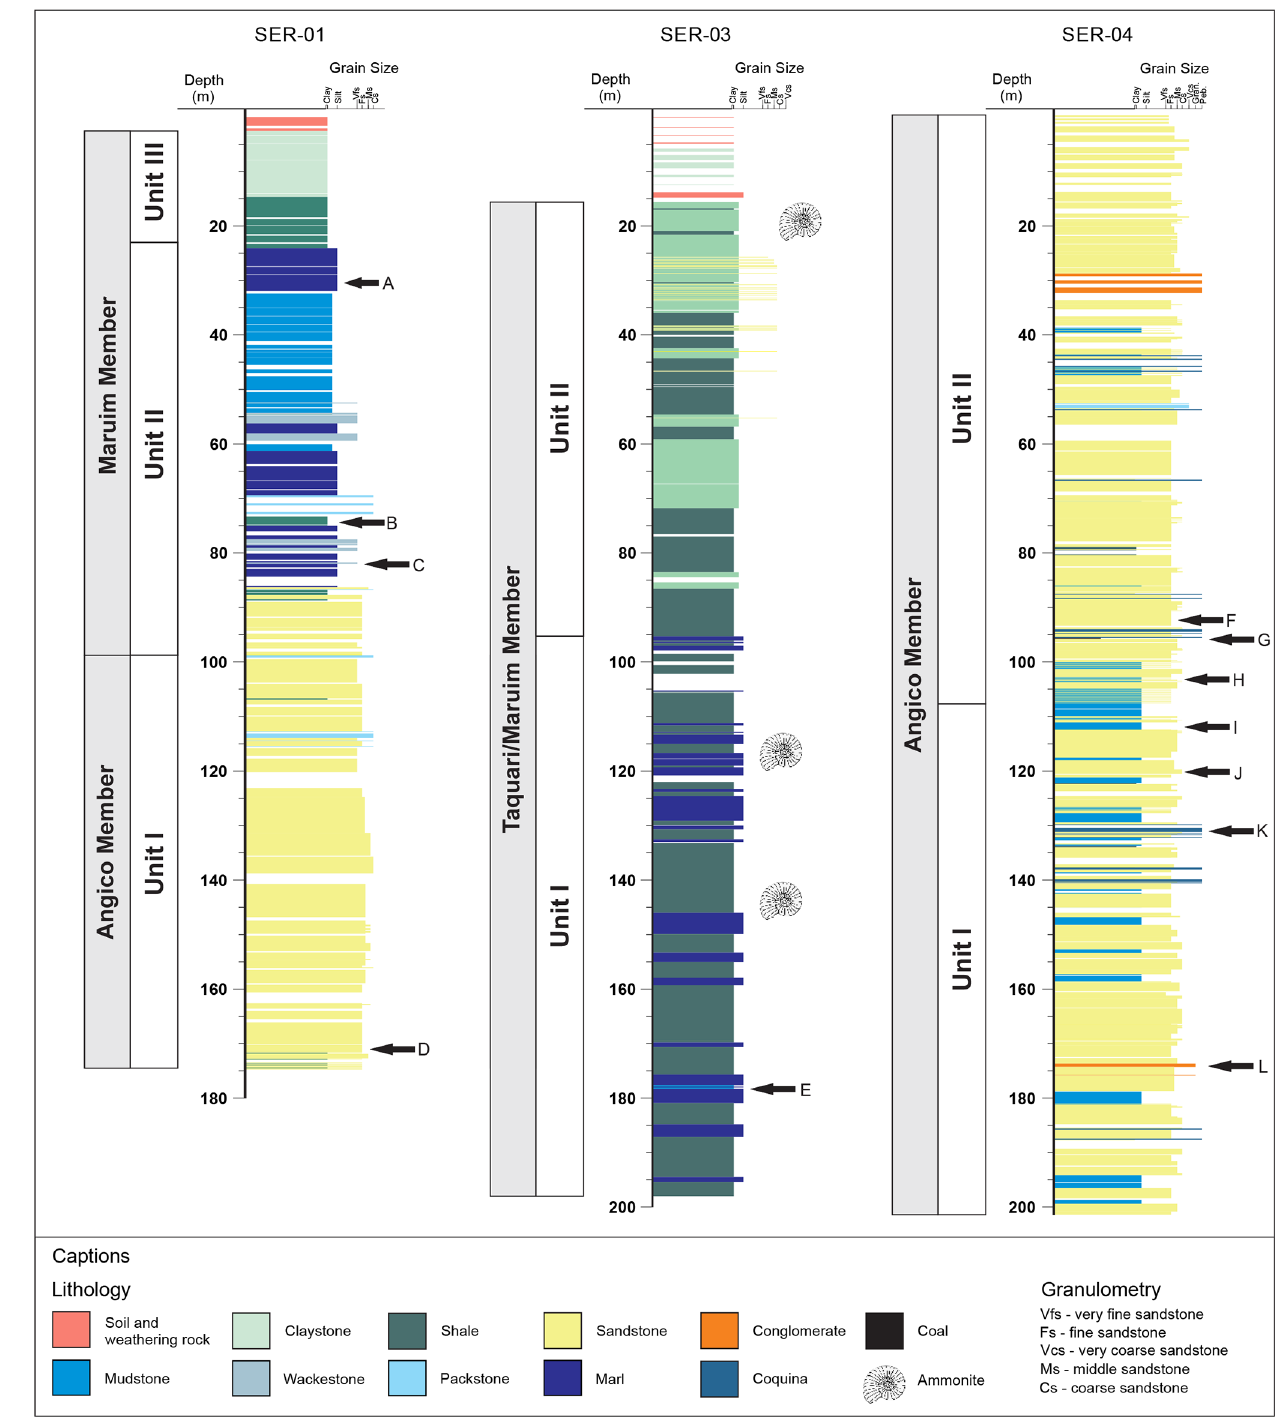
Figure 5. Stratigraphic sections of the Early Cretaceous cores (Aptian–Albian interval) from the Riachuelo Formation (Sergipe–Alagoas Basin), showing the distinct lithostratigraphic units and ammonites identified for each core. The lithostratigraphic units in each core are tentatively assigned to the different members identified in the deposits from the Riachuelo Formation. The levels (black arrows) at which detail pictures of different lithologies were taken are indicated (see Fig.